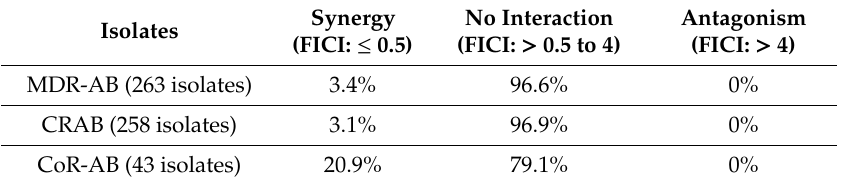
Table 2. Distribution of FICI values for the combination of colistin and sitafloxacin against A. baumannii. Synergy No Interaction Antagonism Isolates (FICI: ≤ 0.5) (FICI: > 0.5 to 4) (FICI: > 4) MDR-AB (263 isolates) 3.4% 96.6% 0% CRAB (258 isolates) 3.1% 96.9% 0% CoR-AB (43 isolates) 20.9% 79.1%